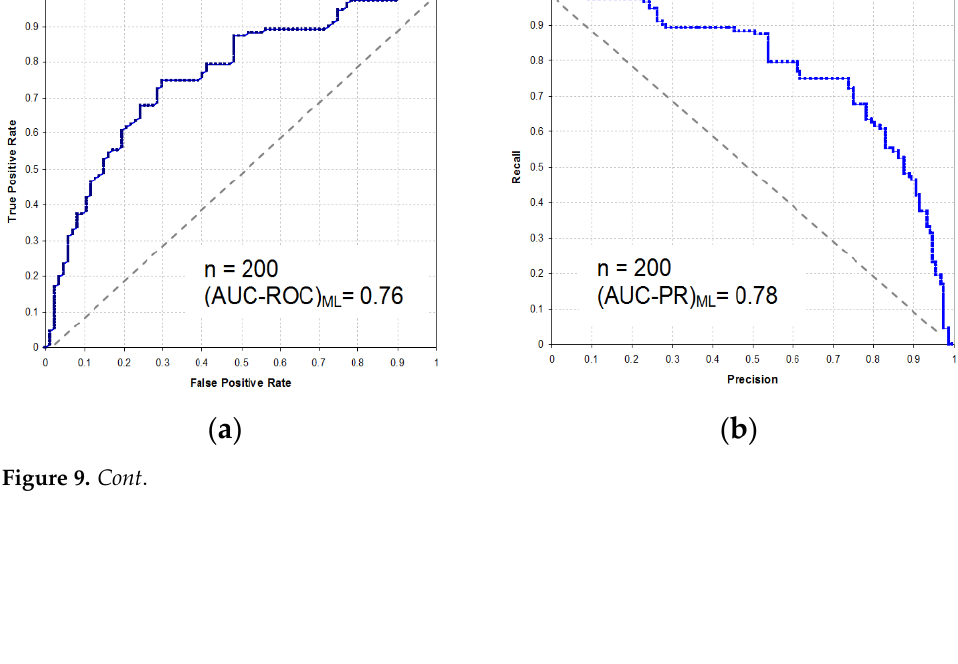
( d ) Figure 9. Comparative characteristics of the ML-models in ROC and PR space for different sample sizes: ML-model in AUC-ROC space where n = 200 ( a ), ML-model in AUC-PR space where n = 200 ( b ), ML-model in AUC-ROC space where n = 300 ( c ), and ML-model in AUC-PROC space where n = 300 ( d ). Thus, when predicting rare events, the machine learning model gave more correct results in comparison with the regression models. To predict risky borrowers, it was pref- erable to use a machine learning model. 5.2. Comparative Analysis of the Proposed Methodology and Models with the Traditional Credit Scoring Model The organization of management decisions to minimize the bank’s credit risks due to inaccurate loan payments by individuals is based on loan portfolio diversification. Di- versification of the bank’s loan portfolio is a method for minimizing credit risk based on the individual lending conditions for each group of borrowers, including loan terms, the types of loan collateral, and the maximum of loan value [69]. Diversification is carried out